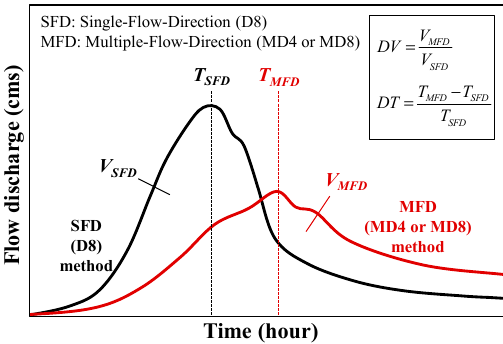
Figure 9. Indicators of hydrograph deviations between the D8 method and an MFD method.